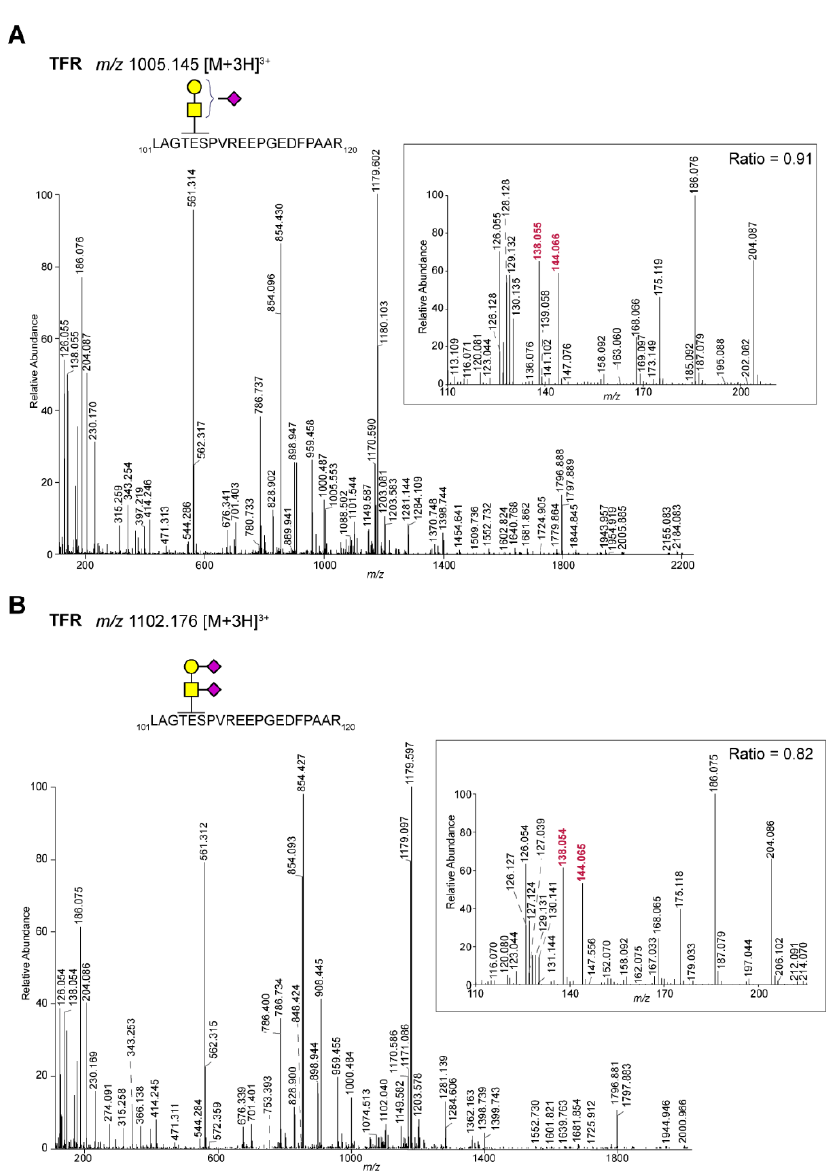
Figure 3. MS/MS spectra of a TMT-labeled tryptic peptide from human transferrin receptor (TFR) carrying a mono and di-sialylated T-antigen. TMT-labeled tryptic peptides form CRC cell lines were analyzed by LC-MS/MS using higher-energy collisional dissociation. The tryptic peptide LAGTESPVREEPGEDFPAAR from TFR was observed with a mono- ( A ) and di-sialylated ( B ) T antigen, respectively. In both spectra a high intensity of the oxonium ion at m / z 144.066 versus 138.055 was observed. The inserts show the TMT reporter (9-plex), oxonium ions and ratio of m / z 144.066/138.055. Samples were labeled as follows: HT29: 126, 127N, 127C; HCT116: 128N, 128 C, 129N; LS174T: 129C, 130N, 130C. Of note, m / z 126.055 represents the oxonium ion [HexNAc- C 2 H 6 O 3 ] + . Yellow square: GalNAc; yellow circle: galactose; purple diamond: N -acetylneuraminic acid. The oxonium ions at m / z 138.055 and 144.066 used for the ratio are shown in red. Overall, the above data show that even from complex datasets, specific O -glycopeptides with O -linked GlcNAc versus GalNAc can be discriminated by the presence and relative abundance of several oxonium ions.